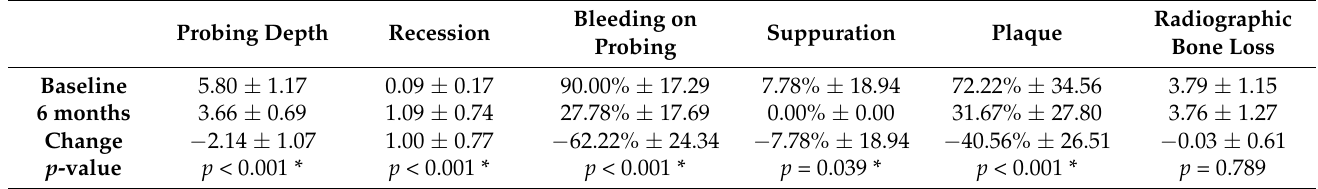
Figure 2. Distribution of implants and sites with probing depths (PD) <3 mm, between 3–5 mm and >5 mm at baseline and at the 6-month visit, expressed as percentages (%). Table 1. Clinical variables, at baseline and 6-month visits, for probing depth, mucosal recession, and radiographic bone loss, expressed in mm (mean ± standard deviation (SD)), and bleeding on probing, suppuration, and plaque levels, expressed as percentage (mean ± SD).